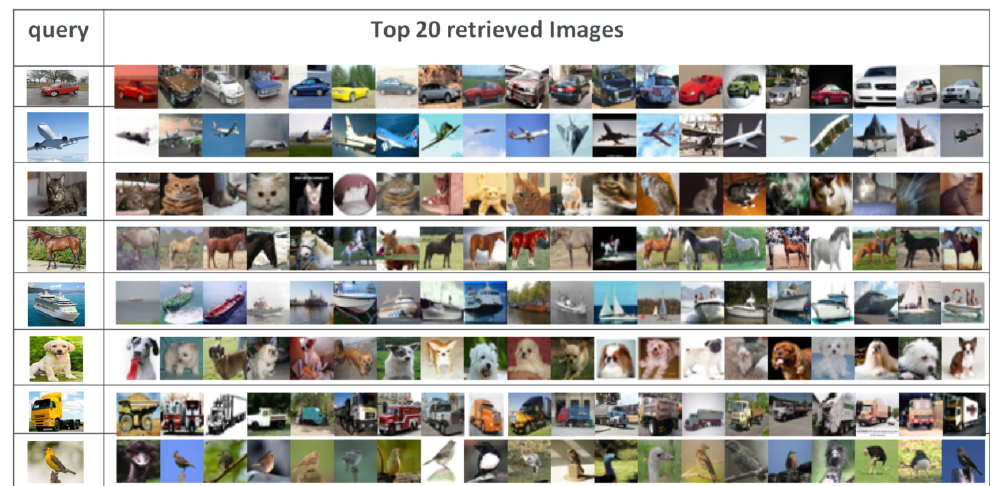
Figure 4. Top 20 retrieved results from CIFAR-10 dataset by DFPH with 48-bit hash codes. The first column shows the query images, the retrieval results of DFPH are shown at other columns.